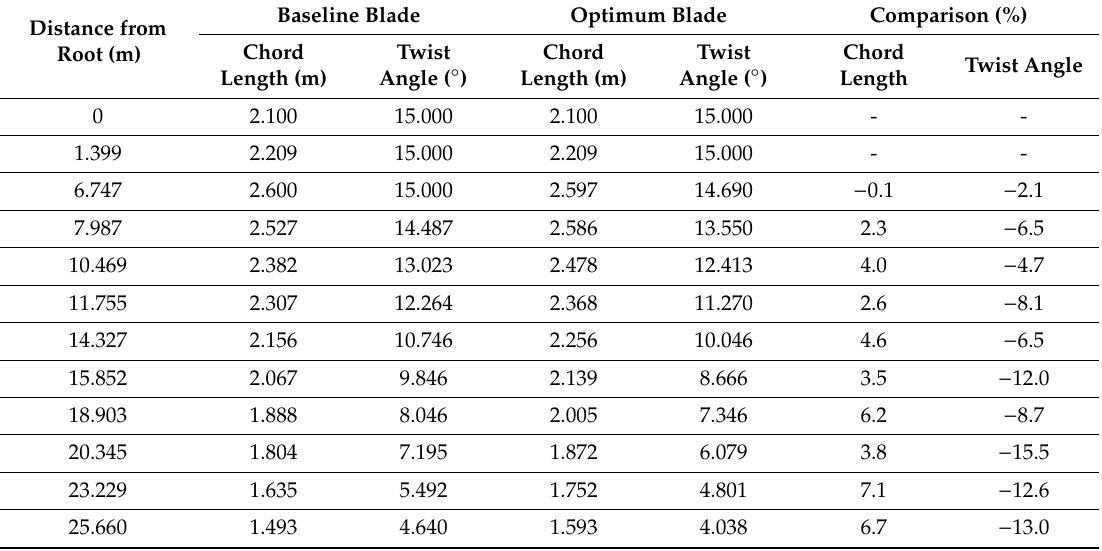
Table 6. Geometric